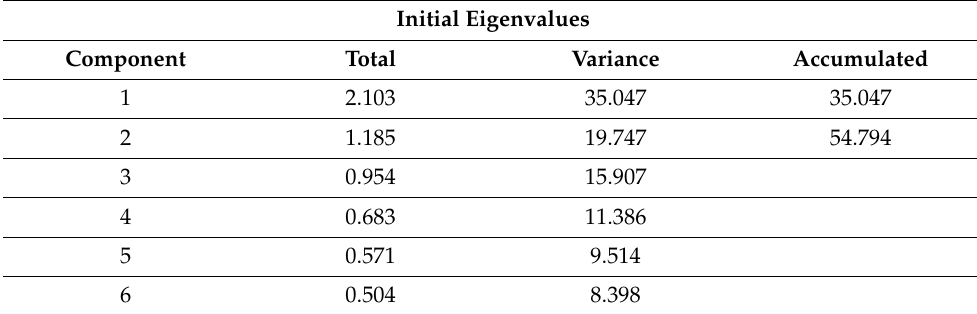
Table 2. Eigenvalues of the extracted components.